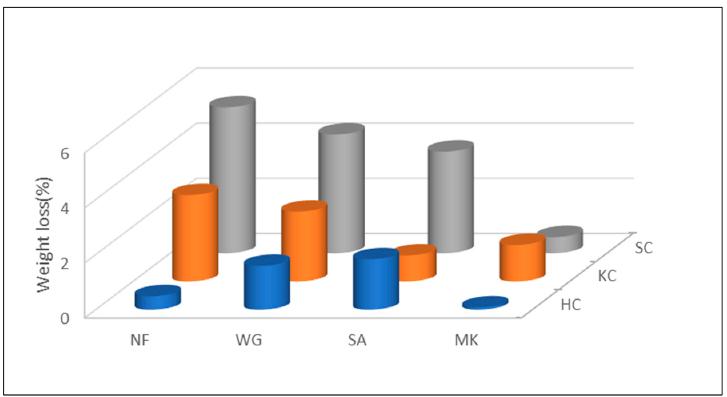
Figure 2. Comparison of weight loss results (%) of HC-, KC- and SC-based samples without (NF) and with the addition of fillers (WG, SAND, MK) after immersion in water for 24 h.